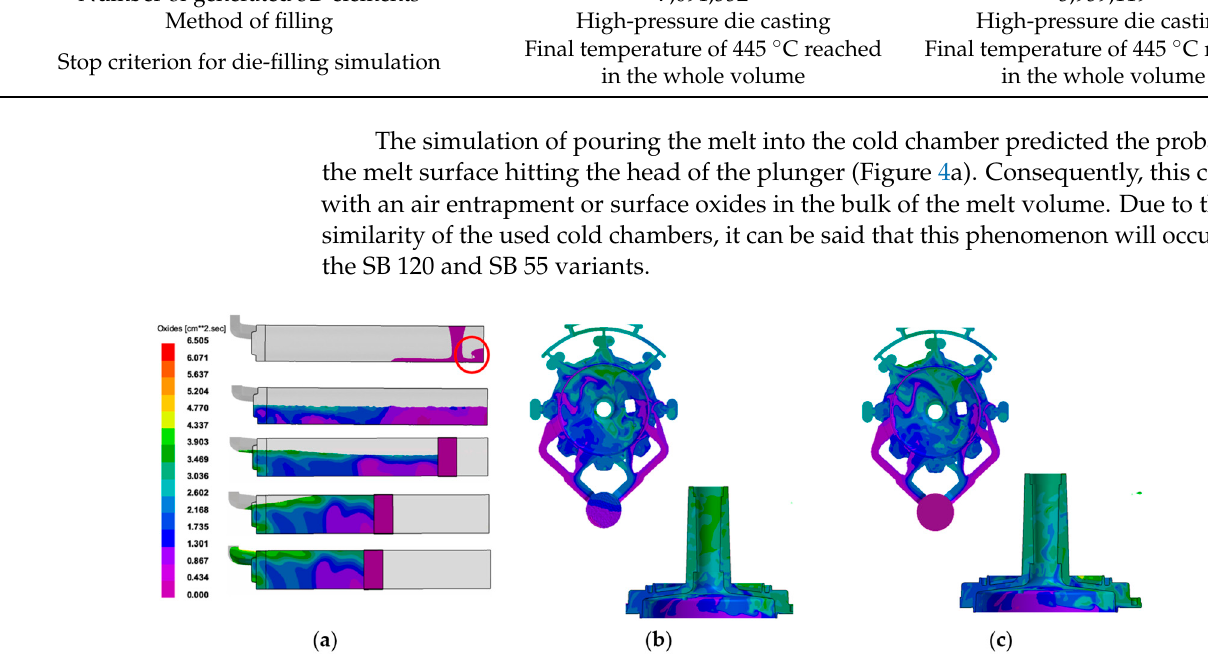
Figure 4. Oxide presence simulation: ( a ) filling chamber, ( b ) SB 120 2 m.s − 1 and ( c ) SB 120 4 m.s − 1 .